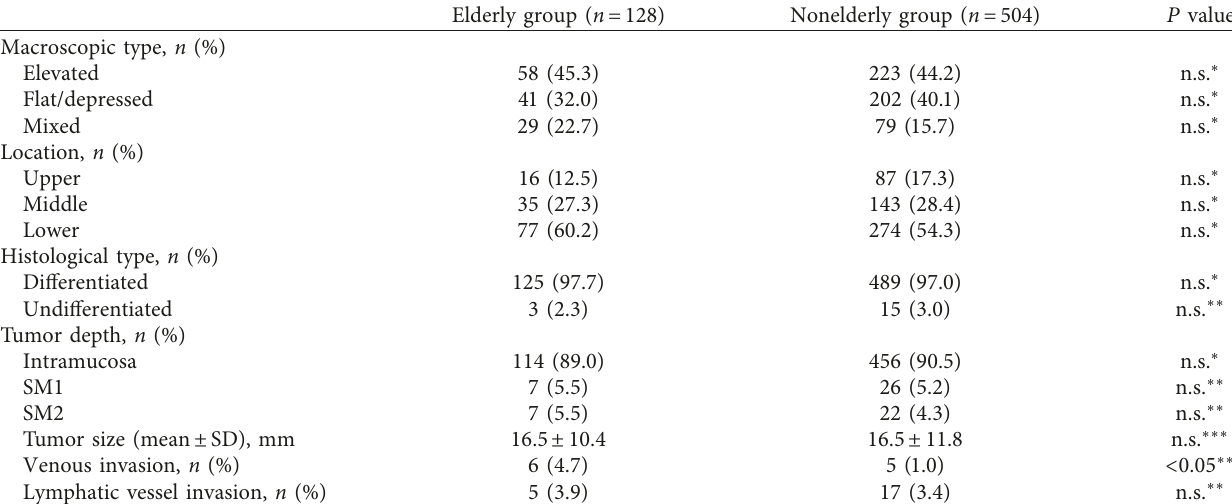
Table 2: Clinical characteristics of the lesions in the elderly and nonelderly groups.